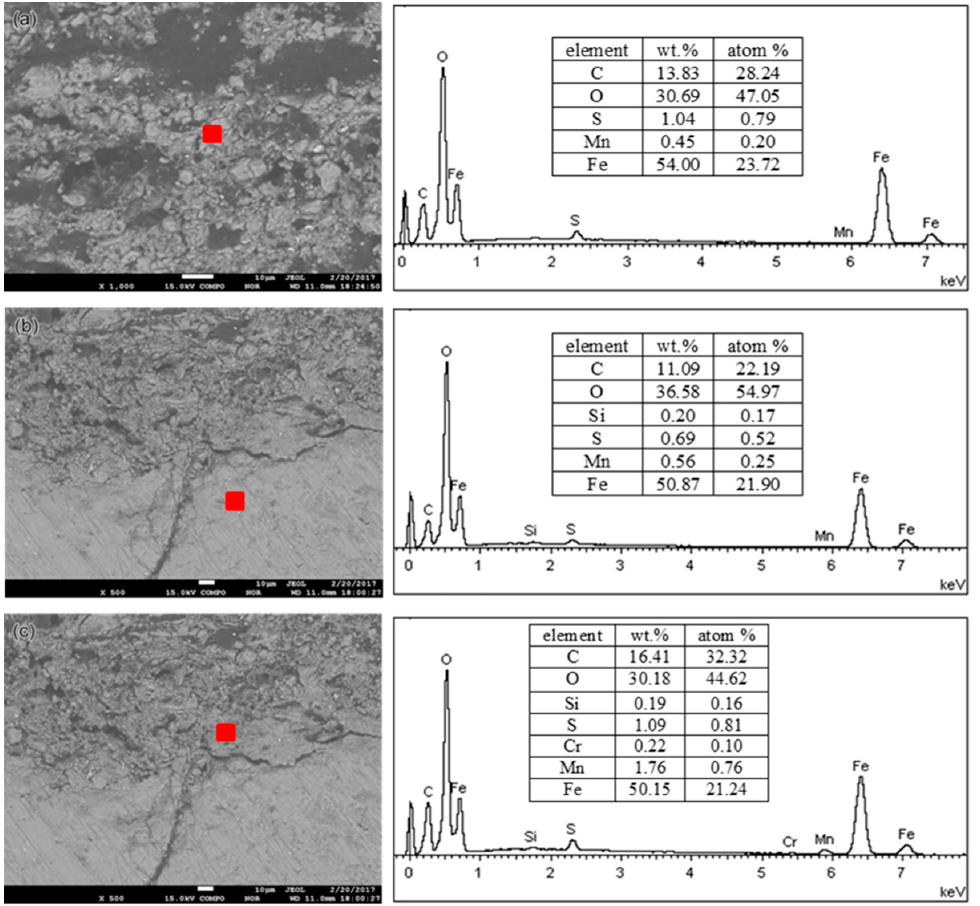
Figure 4. EDS analysis results of corrosion products on the 6 ″ pipe: ( a ) surface, ( b ) inner layer and ( c ) outer layer.